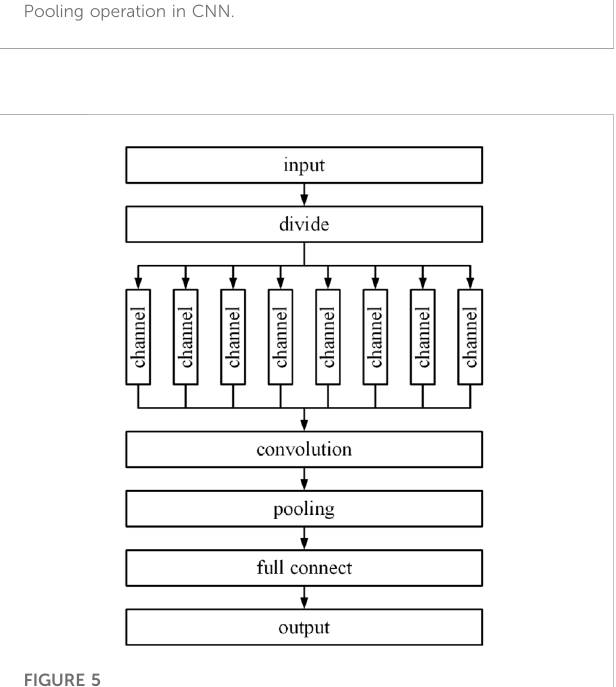
FIGURE 4 Pooling operation in CNN.